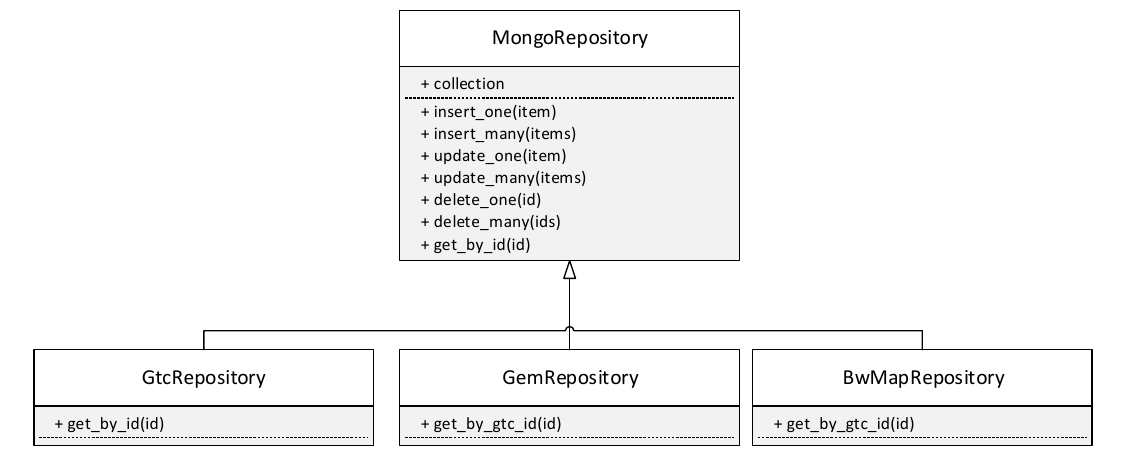
Figure 4. UML diagram—MongoRepository.